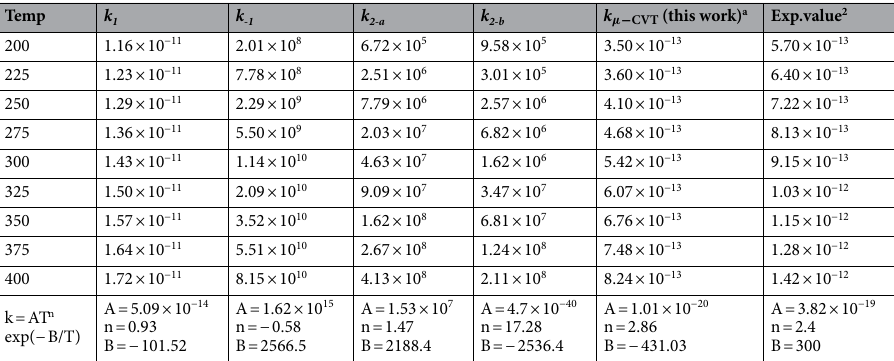
Table 2. Calculated rate coefficients for the OH + CH 3 OH → CH 2 OH/CH 3 O + H 2 O calculated at CC/M06 level.